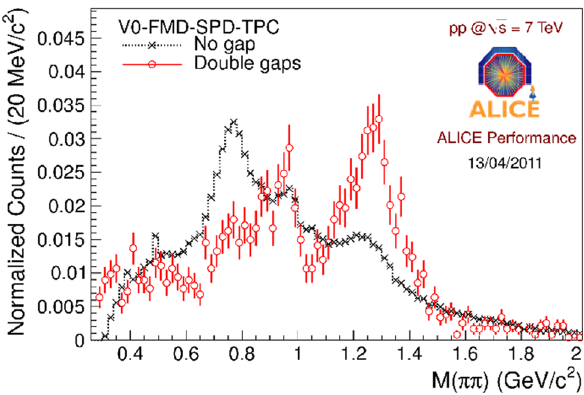
Fig. 3 Invariant mass distributions of pion pairs measured by the ALICE Collaboration (Figure taken from Ref. [3])